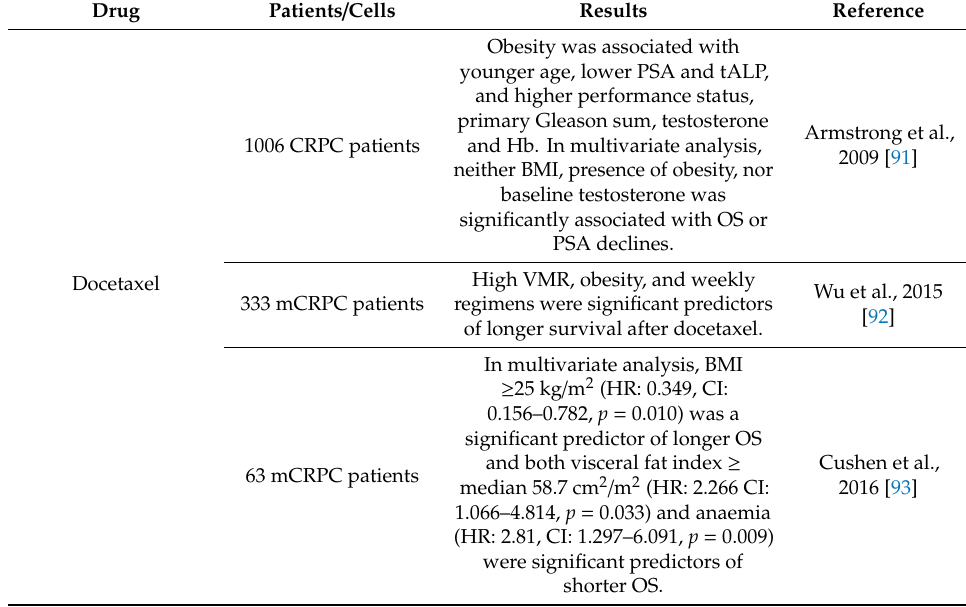
Table 2. Obesity and response to therapy in prostate